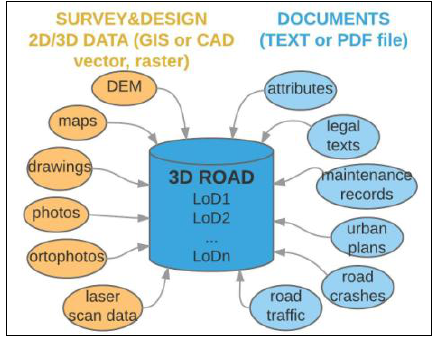
Figure 6 – High Level Overview of the 3D Road